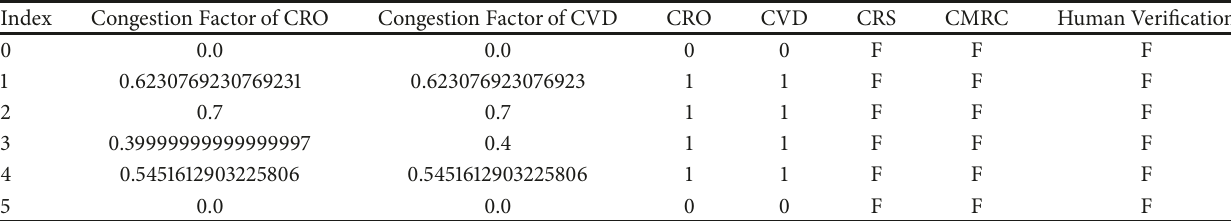
Table 9: Comparison result for road 23572355#2 in Cologne, Germany.